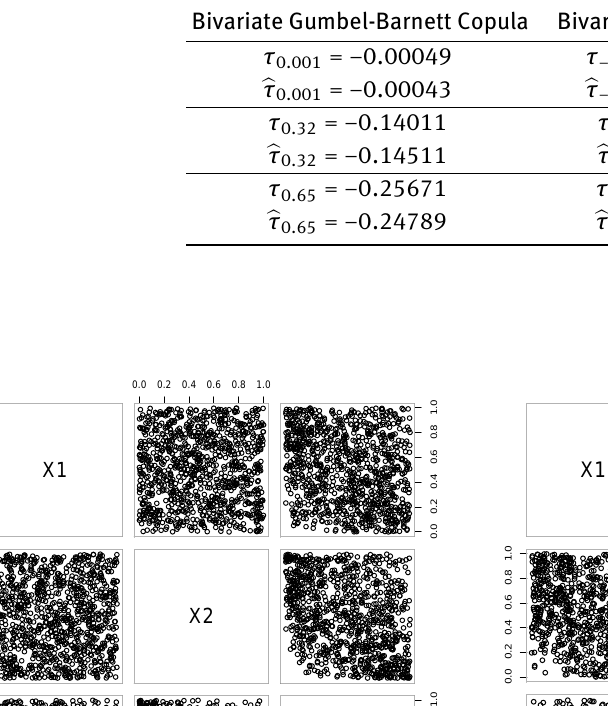
Table 3: Theoretical and estimated pair-wise Kendall’s τ for bivariate Gumbel-Barnett copula (first column) and bivariate FGM copula (second column) for different choices of parameters σ i j .